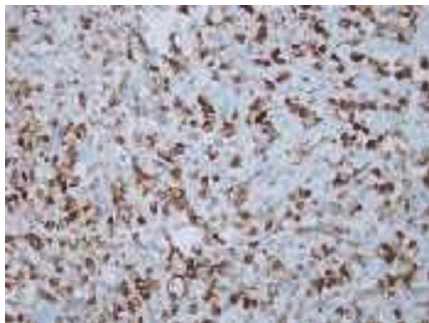
Figure 4: The infiltrative cells are CD34 and CD68